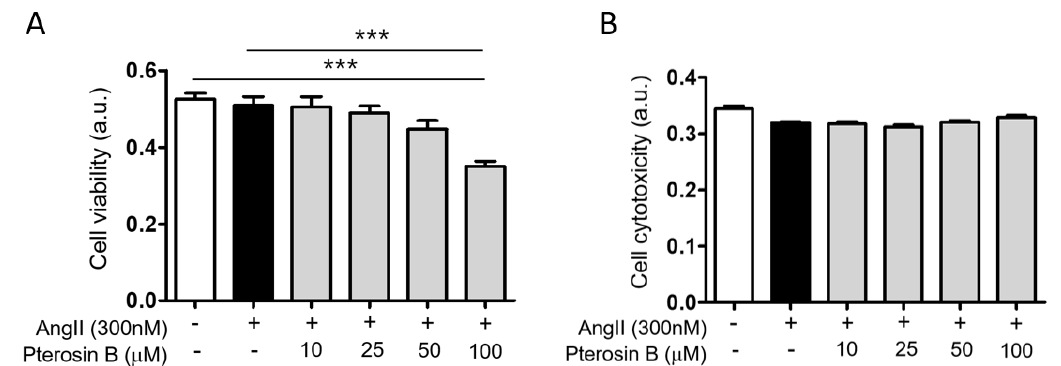
Figure 1. E ff ects of Pterosin B on H9c2 cell viability. ( A ) Cell viability was measured by WST assay, and ( B ) cytotoxicity was measured by LDH assay. Cell viability (CCK) and cytotoxicity (LDH) were measured after treatment with 0–100 µ M Pterosin B for 48 h in the presence of Ang II. Quantitative data were expressed as the mean ± SEM of three independent experiments. *** p < 0.001.